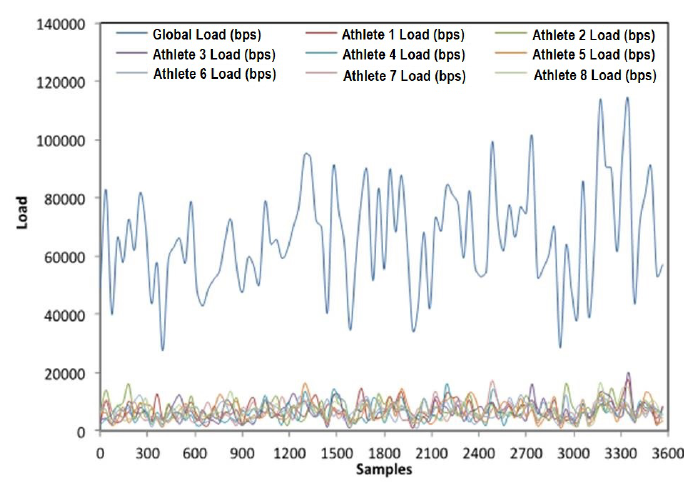
Figure 5. Load in the network in bits per second.